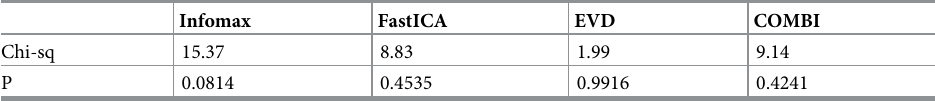
For each non-deterministic algorithm, the Iq values of different repetition number k ( k = 10, 20, 30, 40, 50, 60, 70, 80, 90, and 100) did not present statistically significant difference (Kruskal–Wallis test).